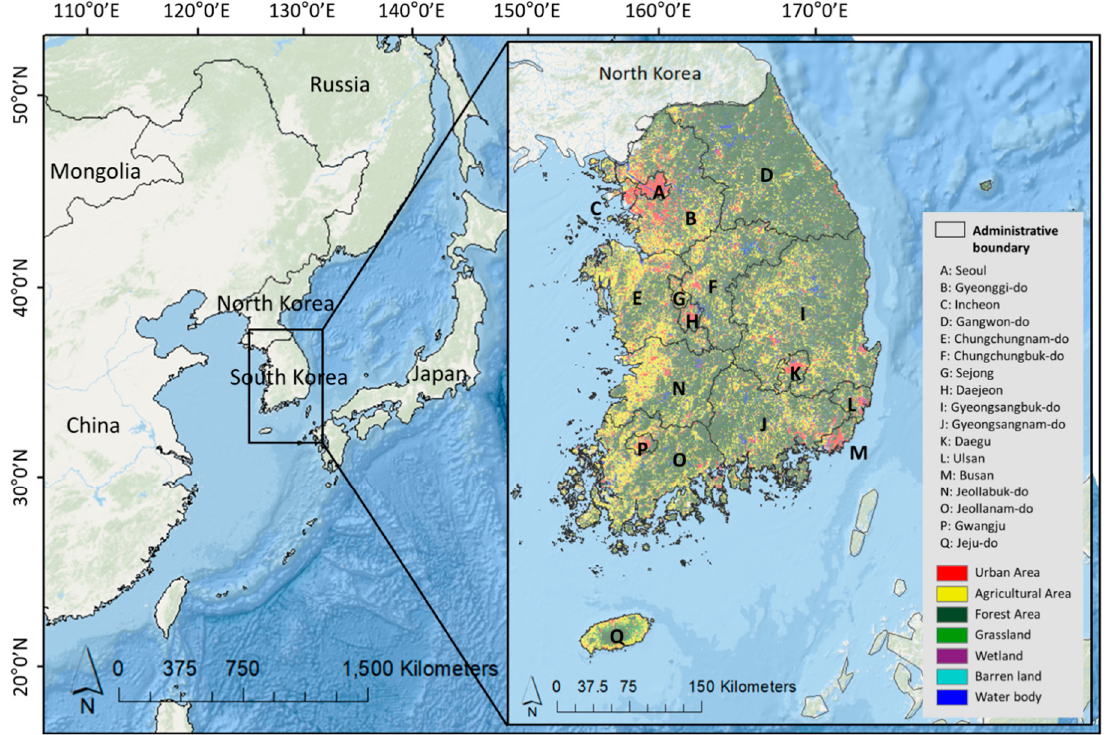
Figure 2. Study area and its land cover map (2007) from the Ministry of Environment of the Republic of Korea.